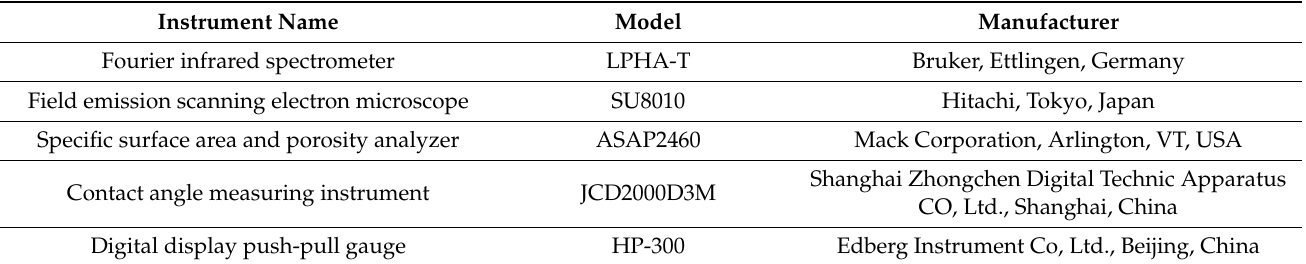
Table 2. Test equipment.